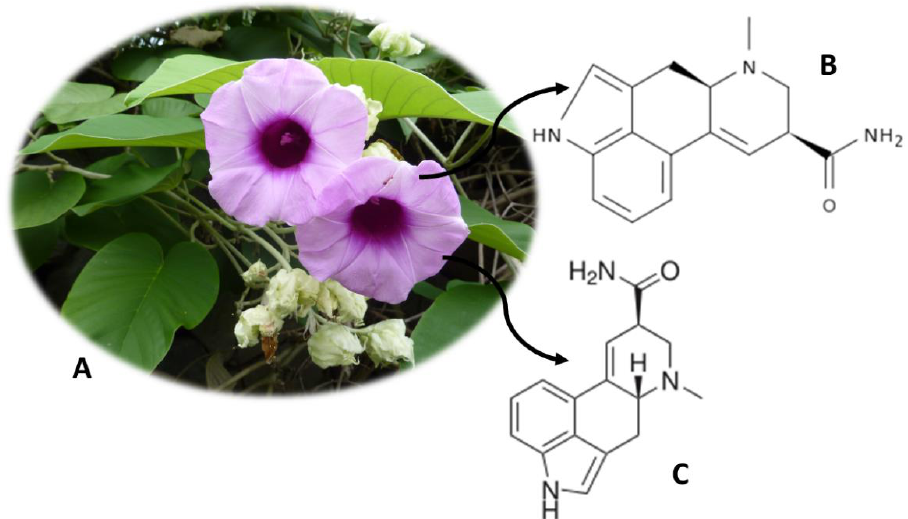
Figure 2. Argyreia nervosa ( A ) and the main compounds isoergine ( B ) and lysergamide (LSA) ( C ).